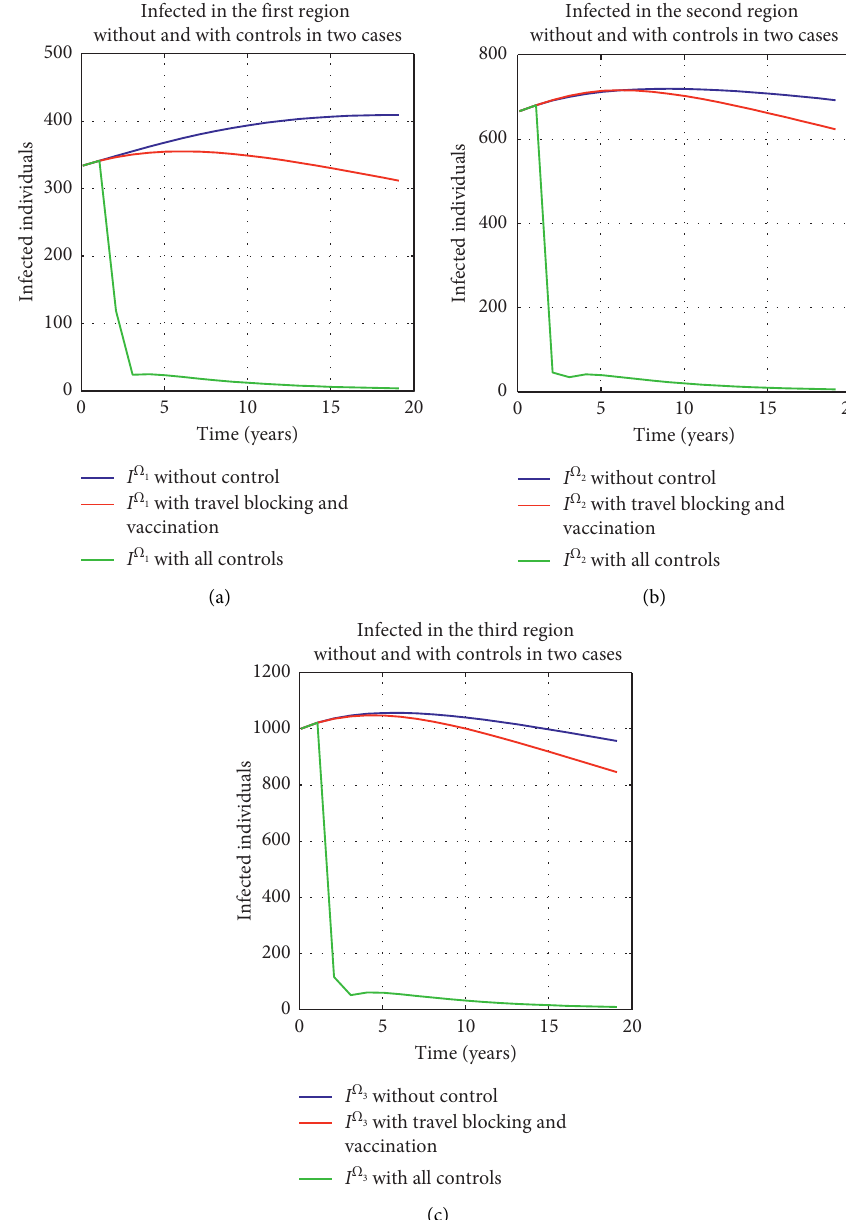
Figure 11: Comparison of the infected in each region without control and with control in two